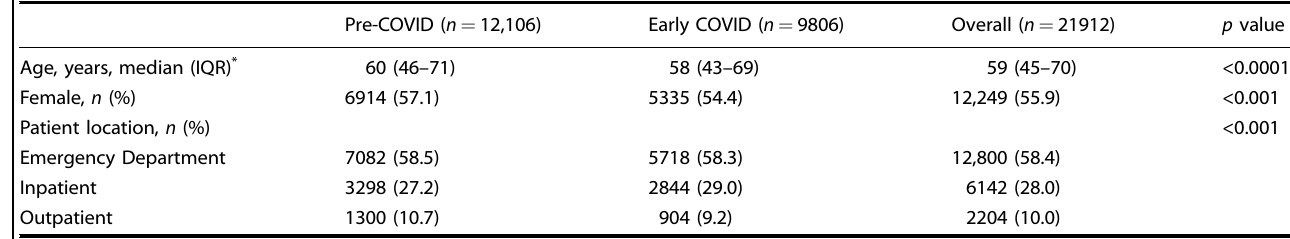
Table 1. Patient